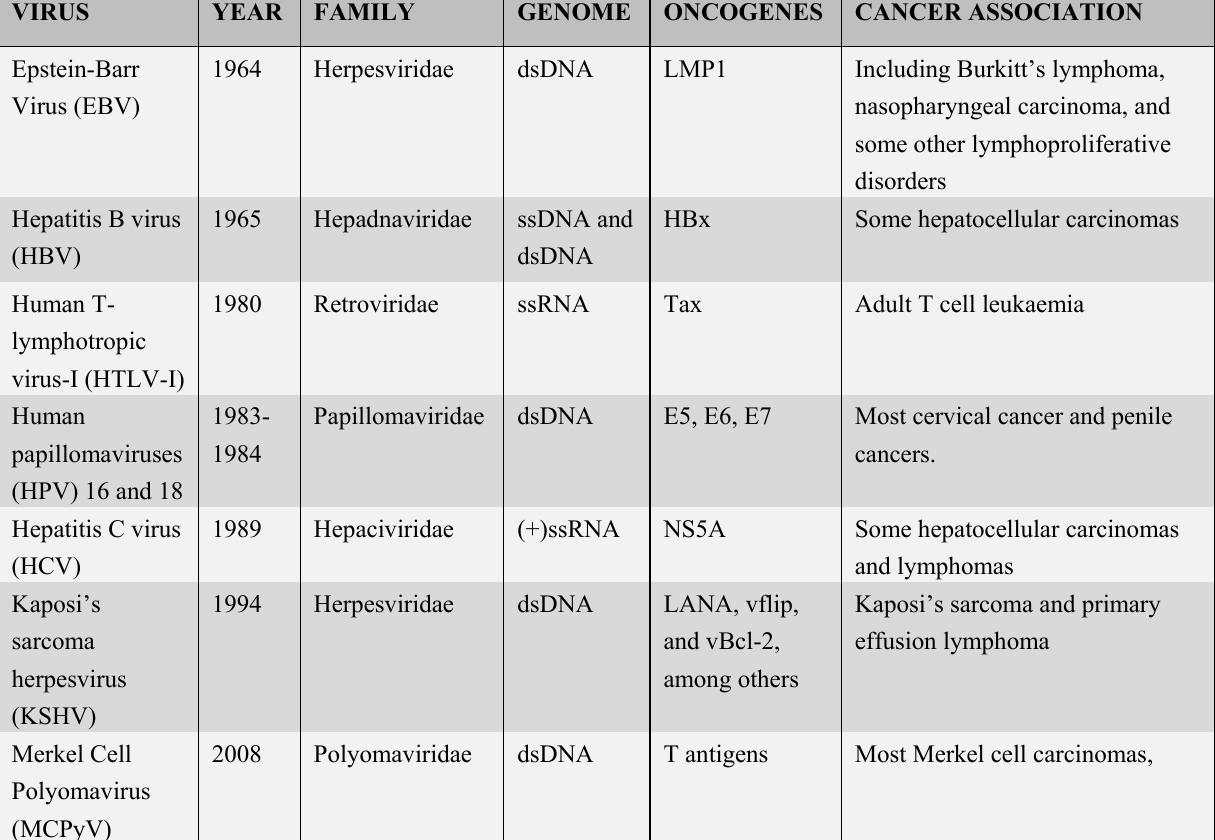
Table 1. The human oncogenic viruses. The seven human oncogenic viruses, their year of discovery, genome and various cancers they are associated with. ds-double-stranded, ss-single-stranded,